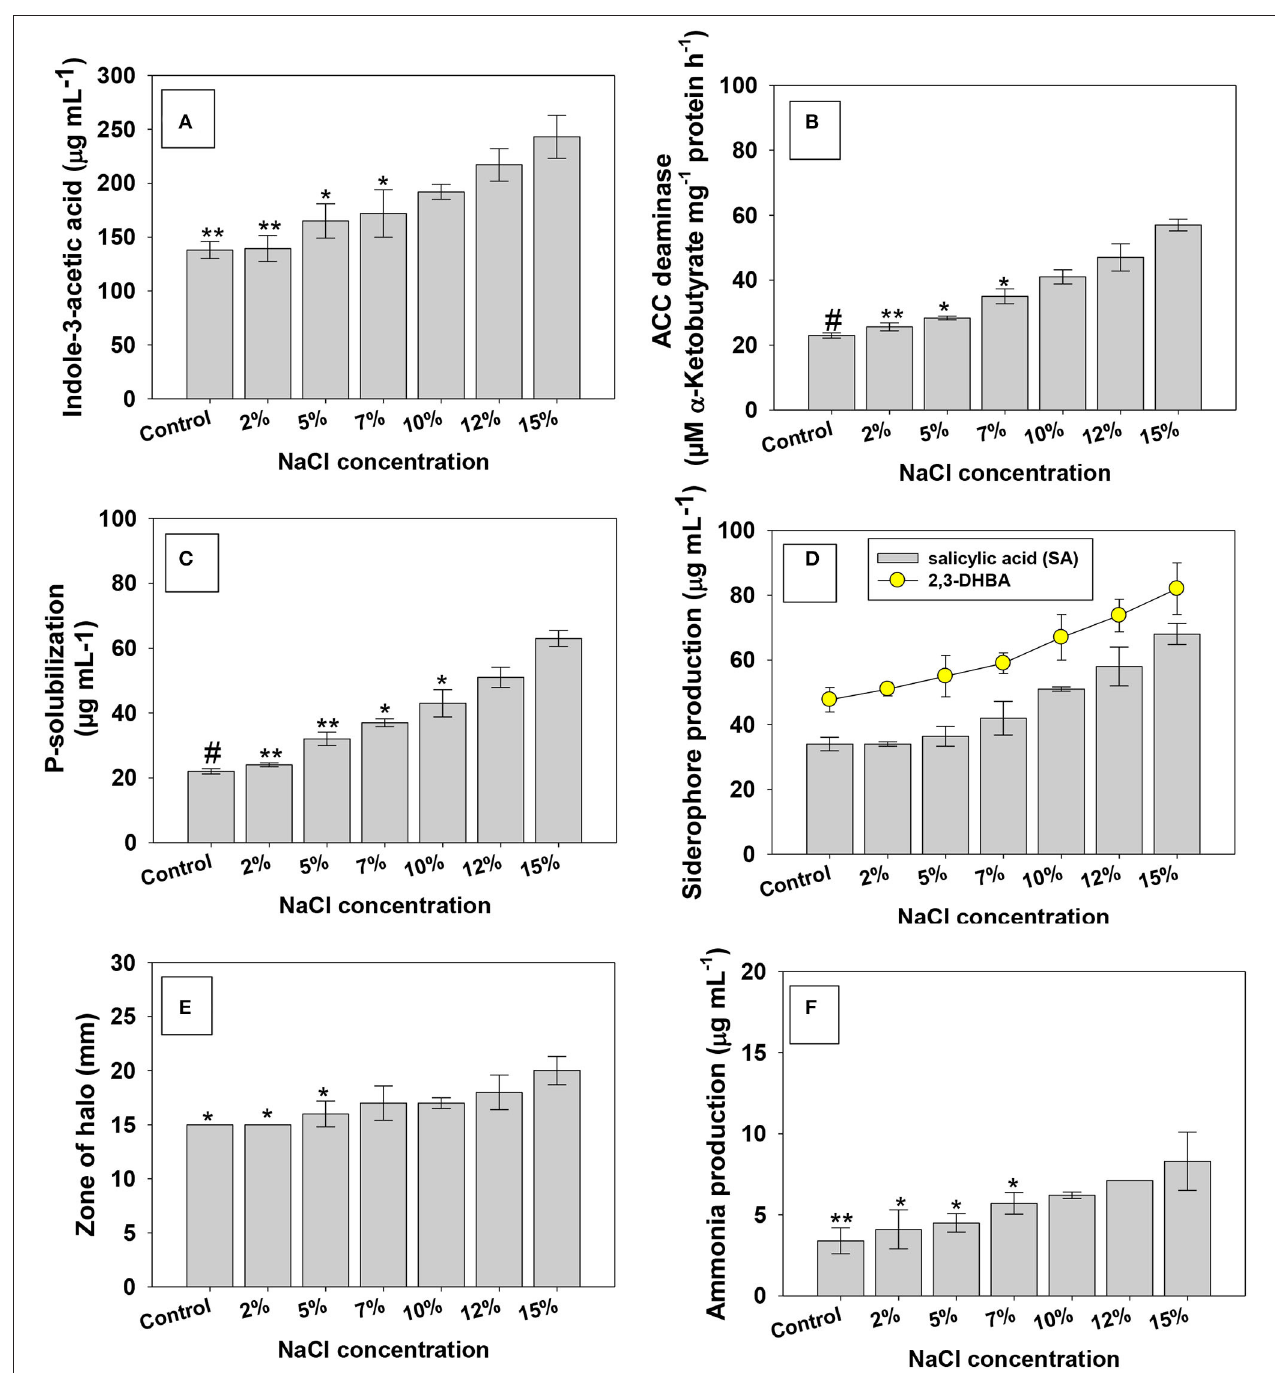
FIGURE 2 | Influence of different levels of the NaCl (0, 2, 5, 7, 10, 12, and 15%) growth-regulating substance secreted/released by PGPR strain under in vitro condition; indole-3-acetic acid (A) ACC deaminase (B) , P-solubilization (C) , siderophore production (D,E) , and ammonia production (F) . In this figure, bar and line diagrams represent the mean values of three replicates ( n = 3). Corresponding error bars represent standard deviation (S.D) of three replicates (SD, n = 3). The asterisks *, **, and # denote statistical significance at p < 0.05, p < 0.005, and p < 0.001, respectively, computed by Student’s T -test.